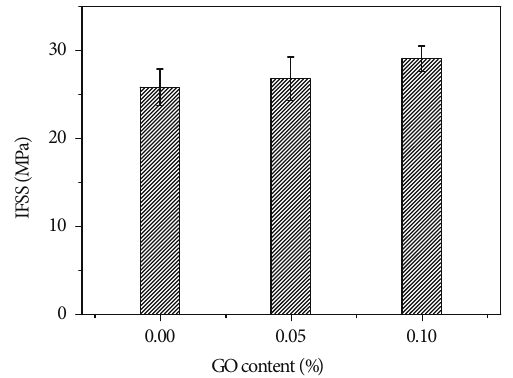
Figure 9: IFSS variation of CFRP composites with the increase of GO